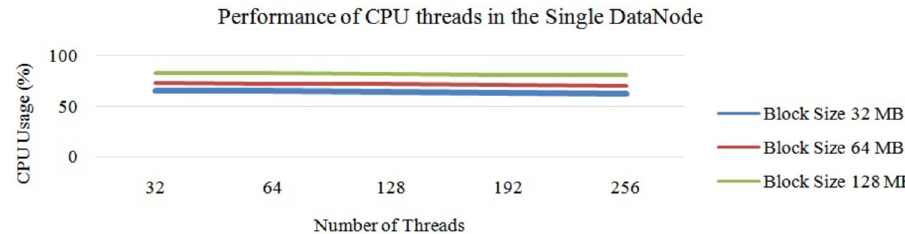
Fig 22. Performance of CPU threads for larger